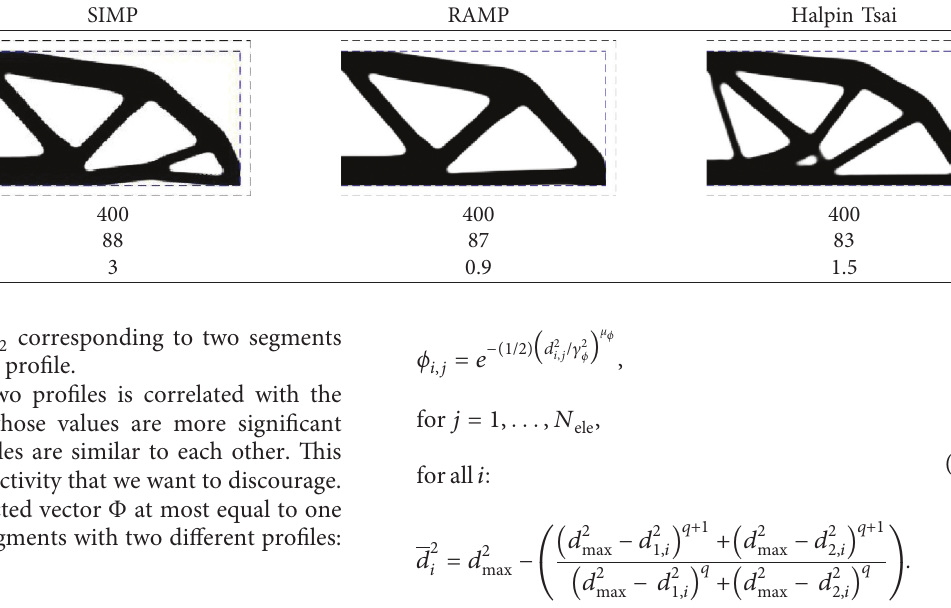
Figure 1: Experimental and numerical comparison layouts b/w the SIMP and RAMP models. Table 1: Experimental and numerical comparison layouts b/w the SIMP and RAMP